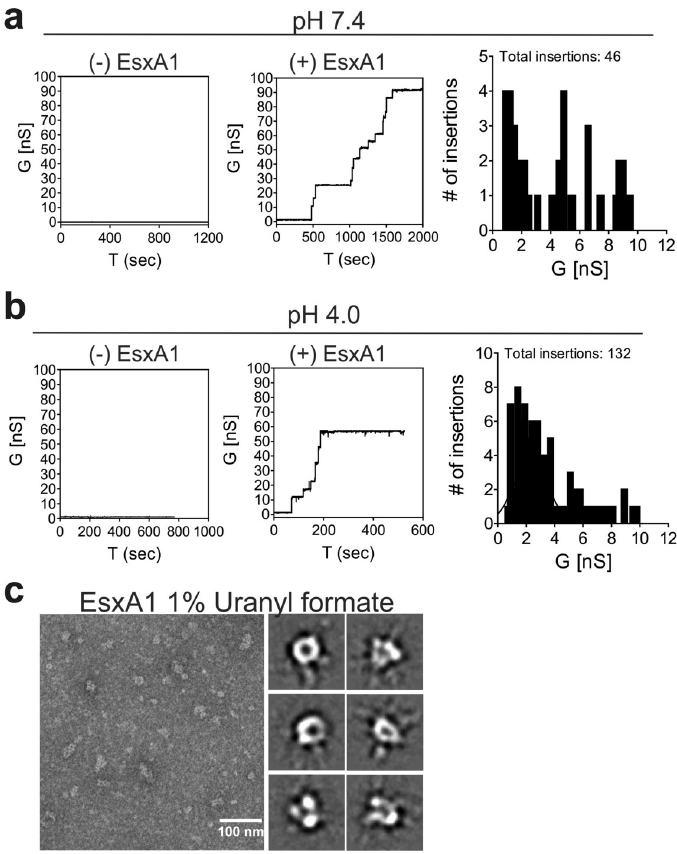
Fig 6. CJB111 EsxA is a pore-forming protein. Lipid bilayers composed of 1,2-diphytanoyl-sn-glycerol- 3-phosphocholine (DphpC), 4ME 16:0 PC were incubated with 5 μ g CJB111 recombinant EsxA at a) pH 7 and b) pH 4.0 in 25 mM sodium phosphate 1M KCl. Representative current traces are shown, and insertion sizes and frequencies are summarized in the histograms. Ten membranes were run in each buffer condition. No protein controls were also performed to rule out artifactual pore formation due to contamination of the system or buffer. Additional current traces can be found in S5A and S5B Fig. c) Transmission electron microscopy of recombinant EsxA1. Shown are EsxA1 particles negatively stained with 1% uranyl formate and selected reference-free 2D class averages from 12,727 particles that resembled an intact oligomeric pore. The full set of class averages can be found in S5C Fig.